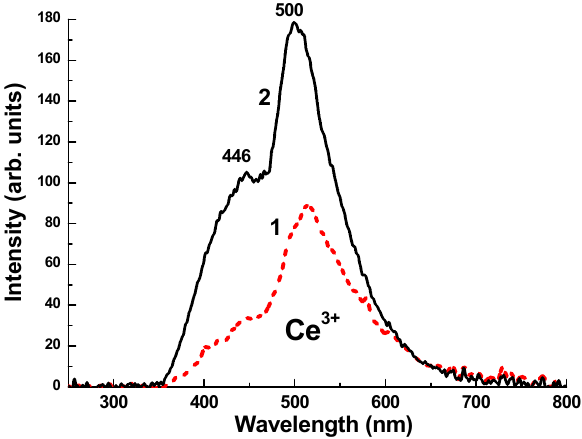
Figure 7. Cathodoluminescence spectra of CeAlO 3 single crystals: 1 , as-grown; 2 , annealed.